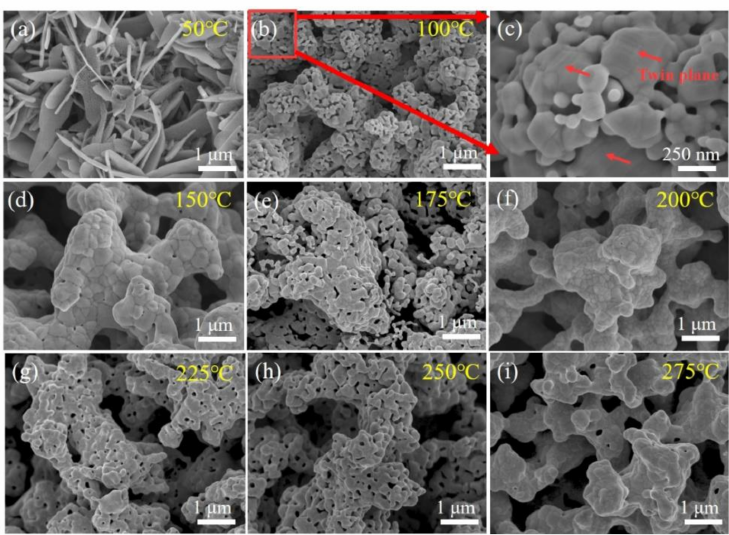
Figure 9. Sintering behavior of Ag agglomerates at the following different temperatures for 5 min under Pt-catalyzed formic acid vapor: ( a ) 50 ◦ C, ( b ) 100 ◦ C, ( c ) high-magnification image of ( b ),